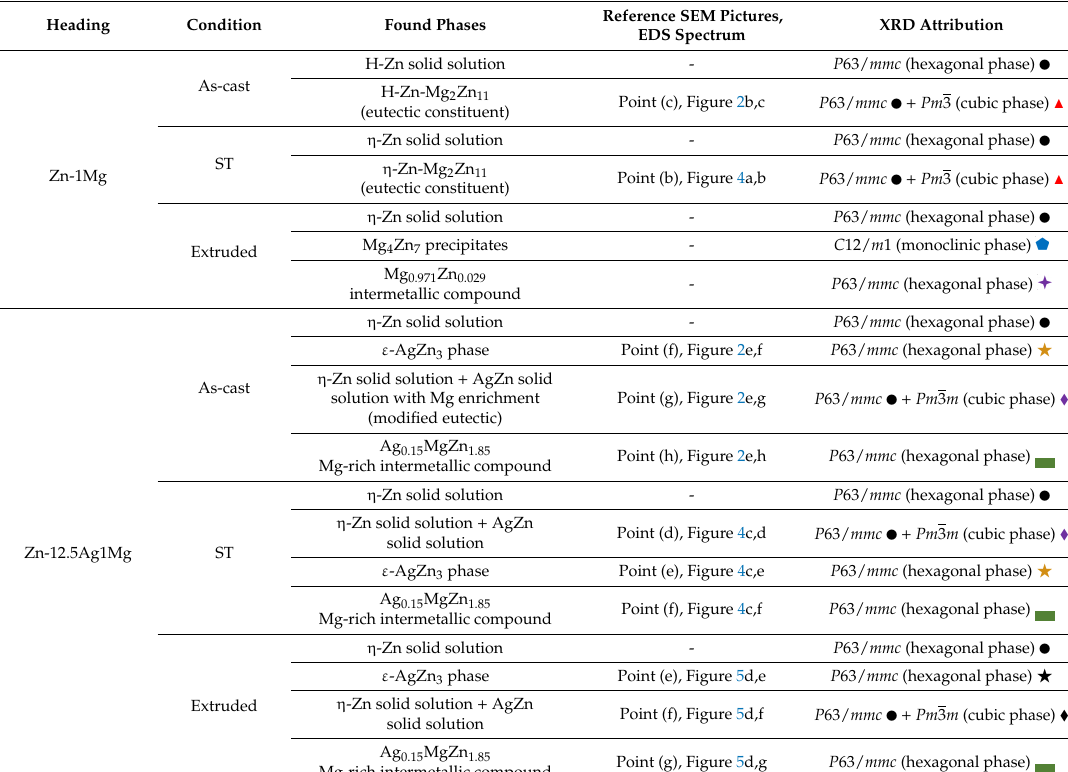
Table 2. Summary table of EDS and XRD results for pure Zn, Zn-1Mg, and Zn-12.5Ag-1Mg alloys with di ff erent processing